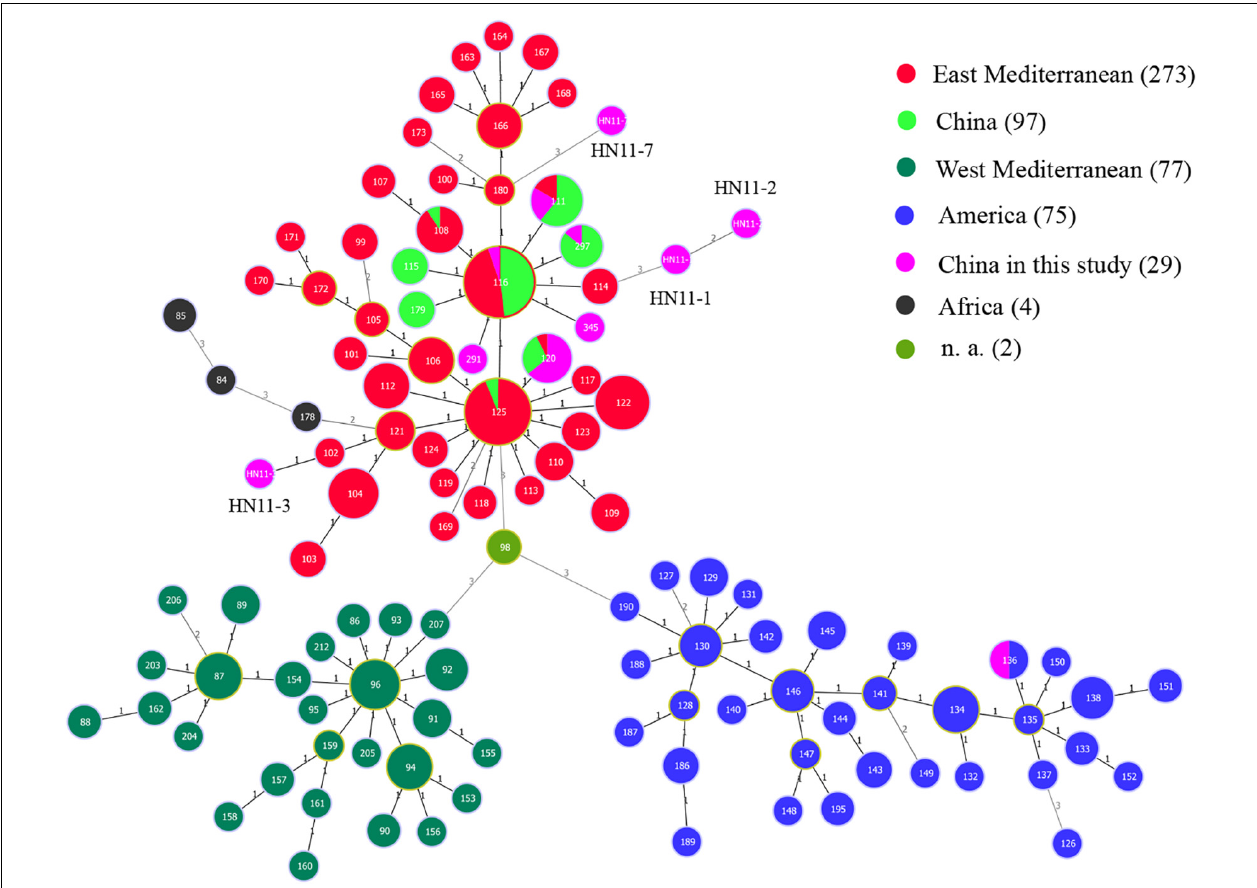
FIGURE 3 | A MST for B. melitensis using the MLVA-11 data with the East Mediterranean group (red), the America group (blue), the Africa group (black), and the West Mediterranean group (blackish green) and compared to the China genotypes (green) and China isolates from our study (pink). n. a., not available (light green).